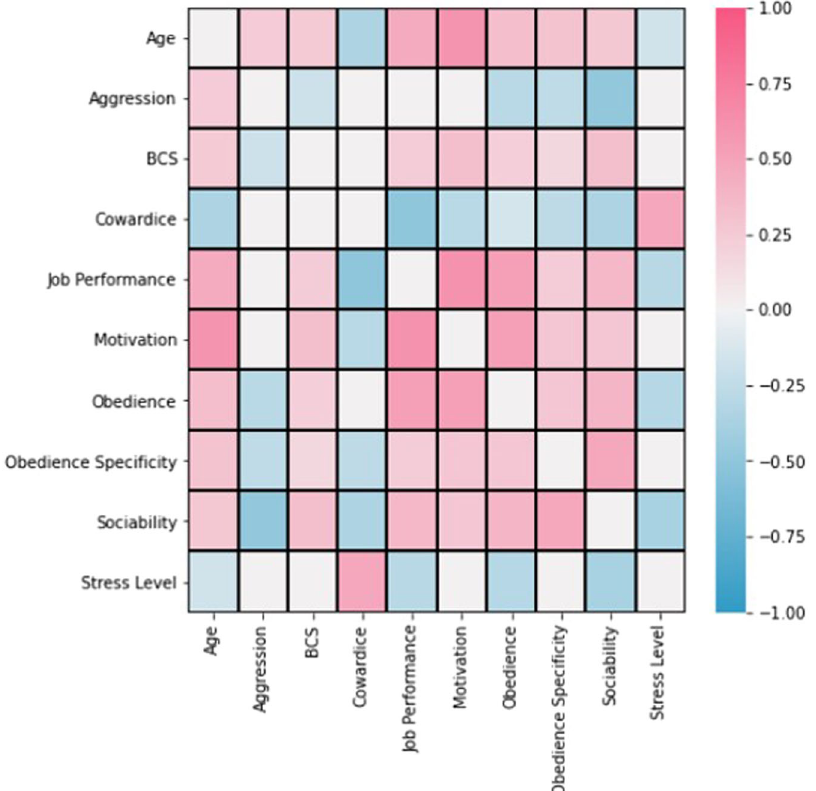
Fig. 6 Heatmap depicting correlation among canine demographic and phenotypic data via Pearson's correlation. Only values after false discovery rate (FDR) correction (level = 0.15) are presented in this fi gure. *BCS Body Condition